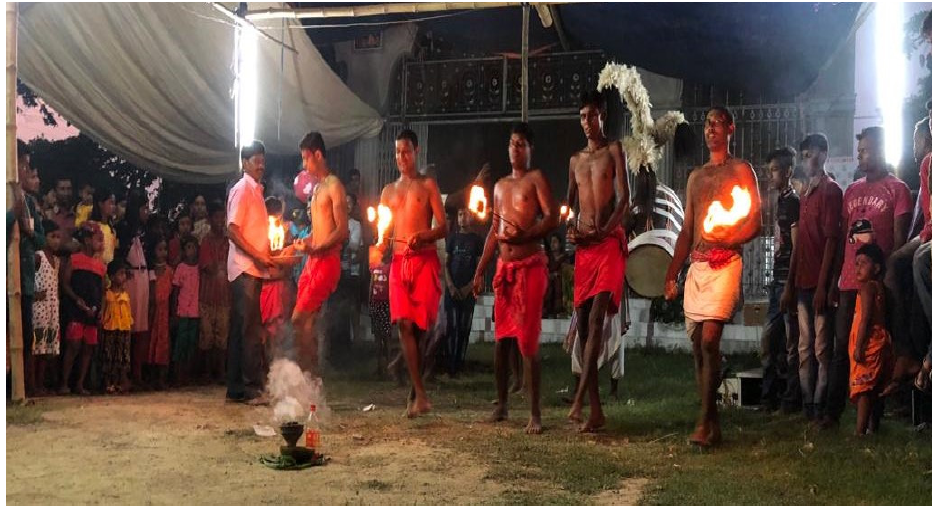
Figure 5. Fire rituals being performed to dhak